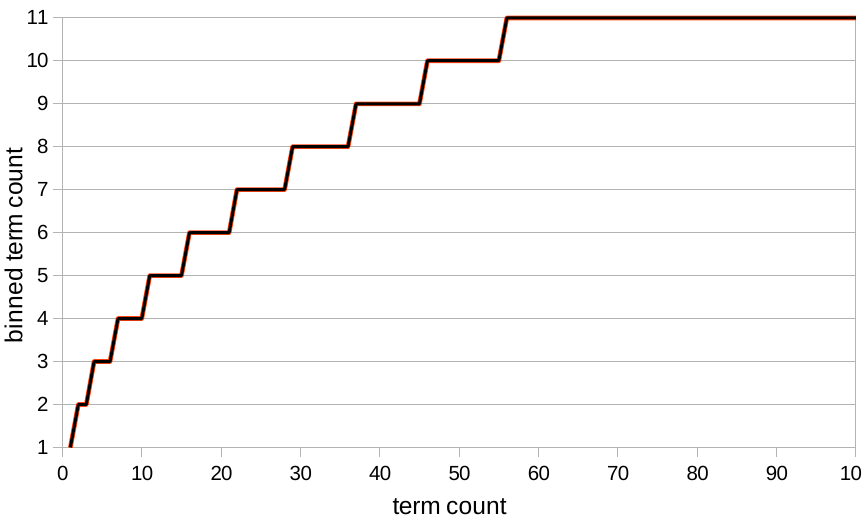
Figure 2. Mapping of term counts to binned term counts. Table 3. BTC values of the terms given in Table 2. Doc Id Category Label Length